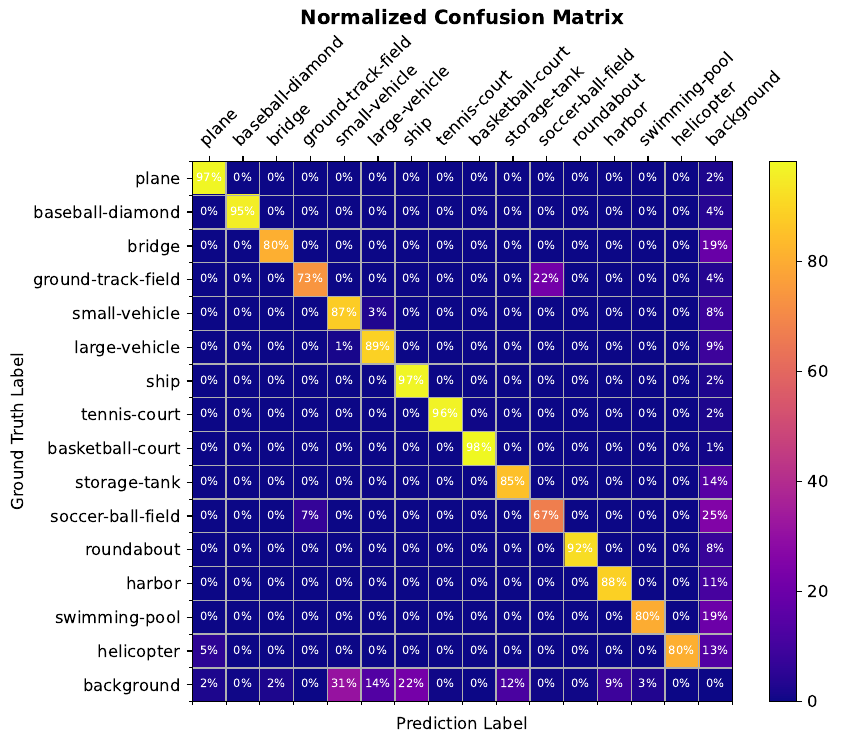
Figure 9. Normalized confusion matrix of detection results on the DOTA validation